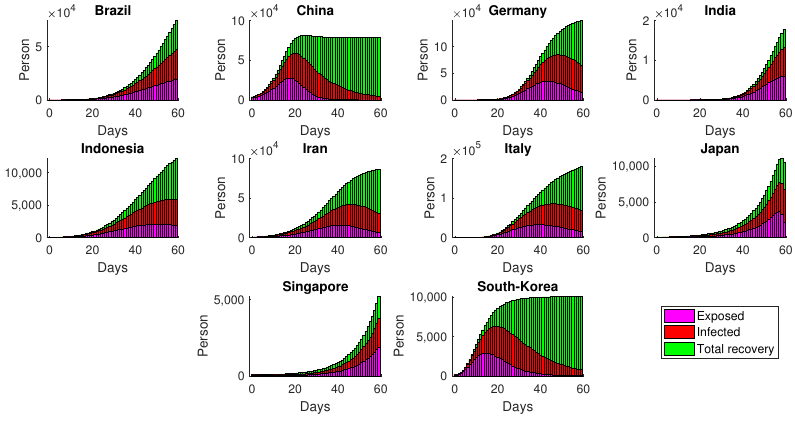
Figure 6. Simulation of estimated SEIR in several countries by implementing the generating